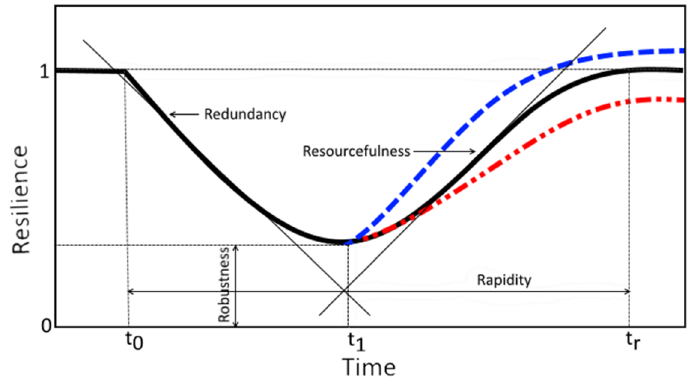
Figure 5. Generic representation of system resilience.